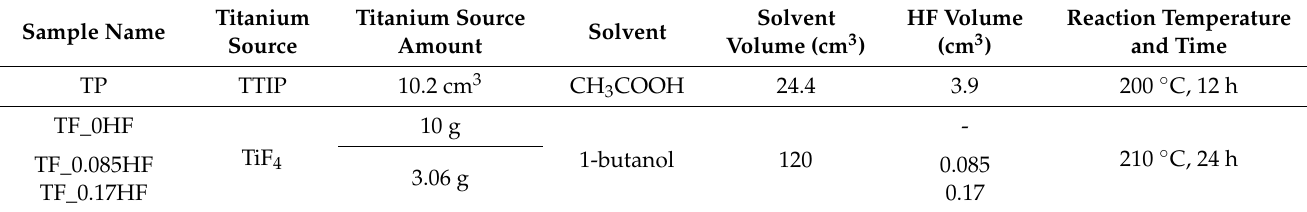
Table 1. Synthesis conditions and nomenclature of TiOF 2